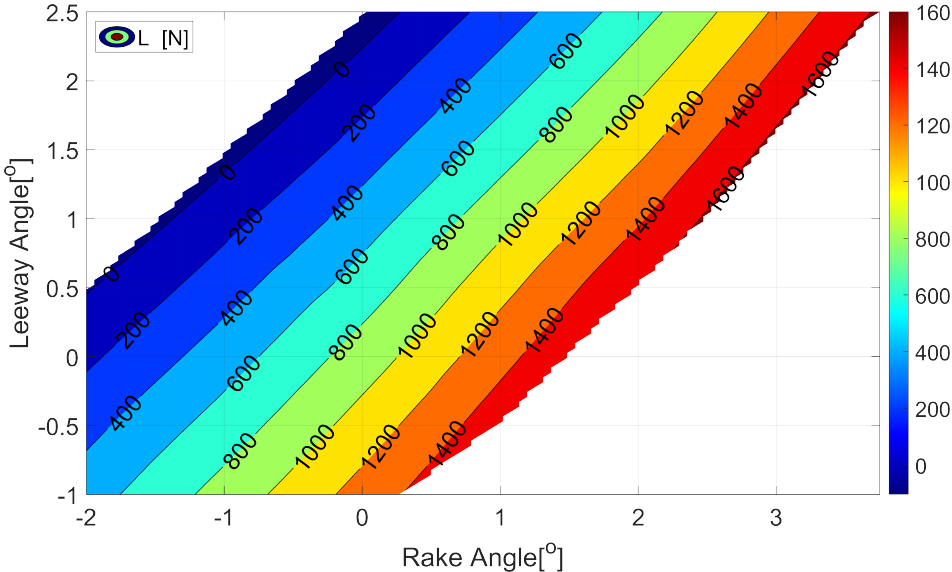
Figure 31. Computed lift force at 9 m/s, dimensions are in